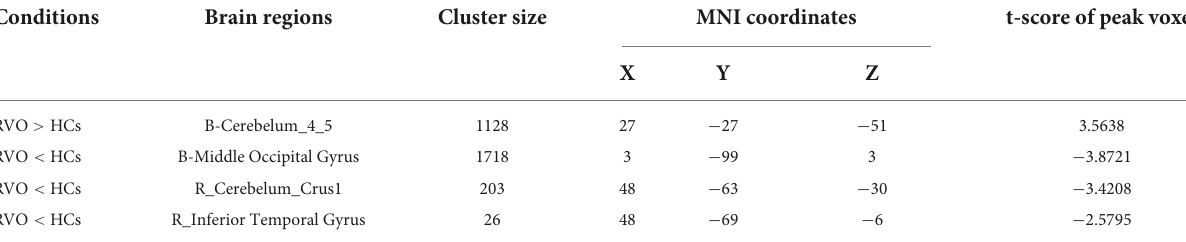
TABLE 2 Brain regions with significantly different ReHo signal values between two